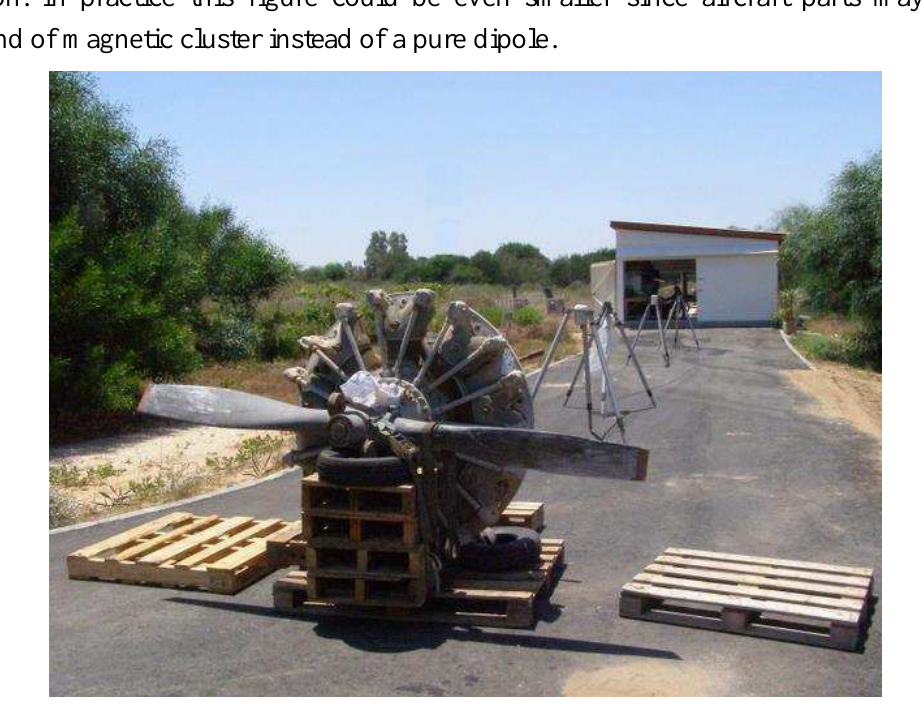
Figure 3. Measurement of engine magnetic